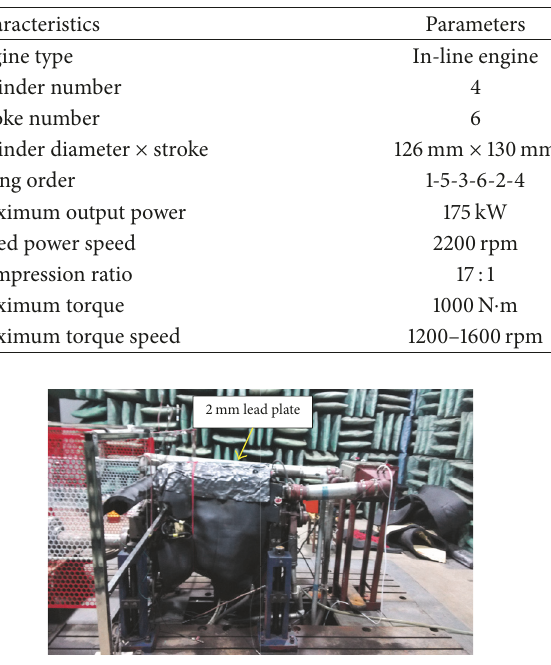
Table 1: Specific parameters of the WP10-240 type diesel engine.